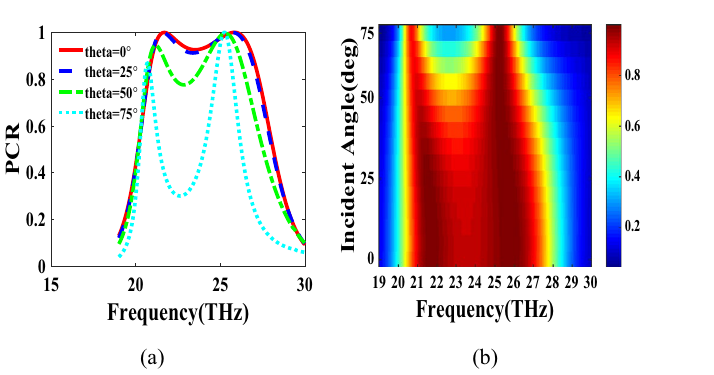
Figure 14. PCR of the second structure for different incident